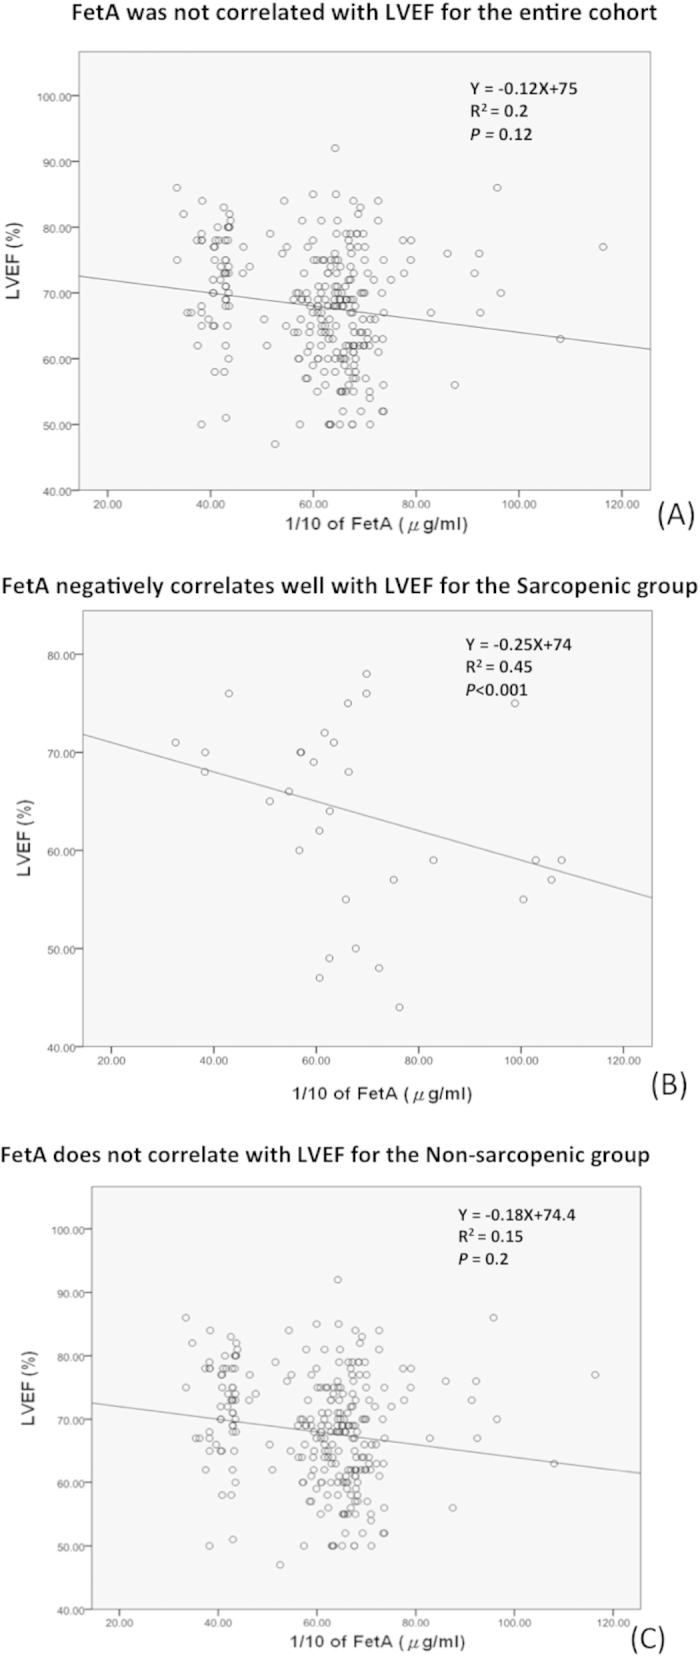
Fetuin-A (FetA) serum concentrations negatively correlated with left ventricular ejection faction (LVEF), significantly in the sarcopenic population.(A) all geriatric participants; (B) in the sarcopenic sub-population and (C) in the non-sarcopenic subpopulation.